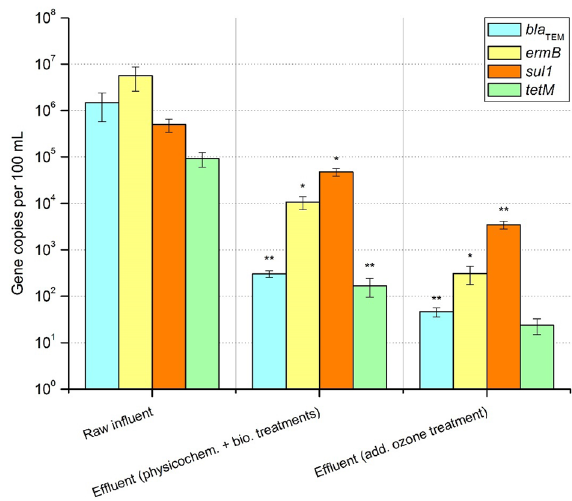
Figure 2. Abundance of “frequent” antibiotic resistance genes in influent and effluent after physicochemical and biological treatments and subsequent ozone treatment. Displayed are mean values with standard deviation. Significance is given by one-tailed nonparametric Mann–Whitney U test calculation and is shown by asterisks (* p ≤ 0.05, ** p ≤ 0.001). Compared are gene copies per 100 mL in (i) raw influent with effluent after physicochemical and biological treatments and (ii) in effluent after physicochemical and biological treatments with effluent after subsequent ozone treatment.